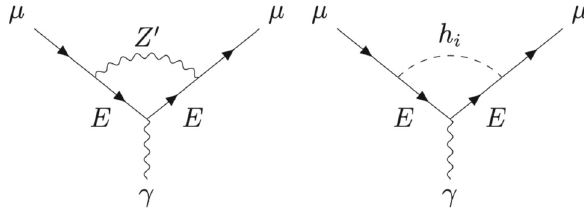
Fig. 1 Feynman diagrams for one-loop corrections to the muon g − 2, with extra gauge boson Z (cid:2) on left and extra scalars h i on right